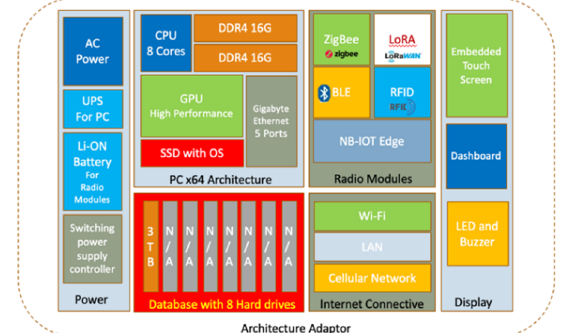
Figure 3. Architecture of GSW Adaptor